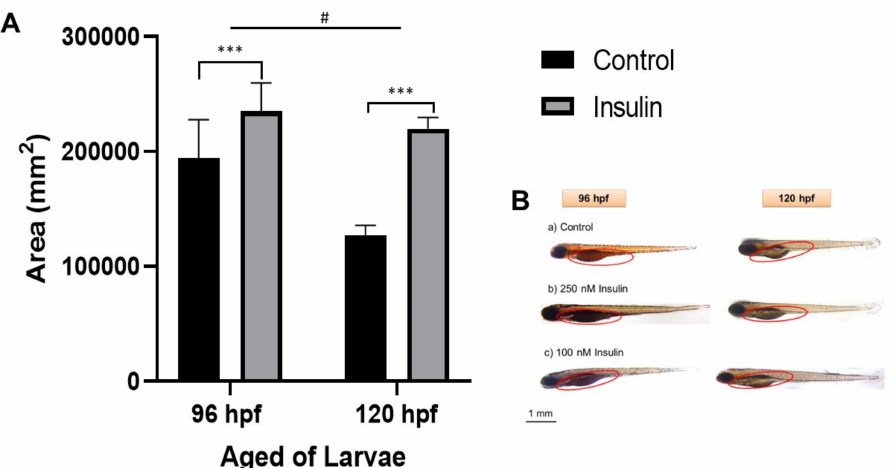
Figure 3. Representative image of whole-mount Oil Red-O (ORO) staining for comparison between control and insulin-induced group larvae (triplicate, pool of three zebrafish per sample). ( A ) The relative area was counted in six replications using ImageJ software for the total area each of area yolk sac to its yolk extension in each larva (mean ± SEM). Two-way ANOVA was applied for the analysis and p -value is expressed as (***). p < 0.001 is comparing to control and (#) p < 0.05 is comparing to the age factor. ( B ) The image of ORO staining in 96 and 120 hpf zebrafish in the lateral view is shown with the enlargement in yolk sac size. The circle is a yolk sac area measurement scale at 1